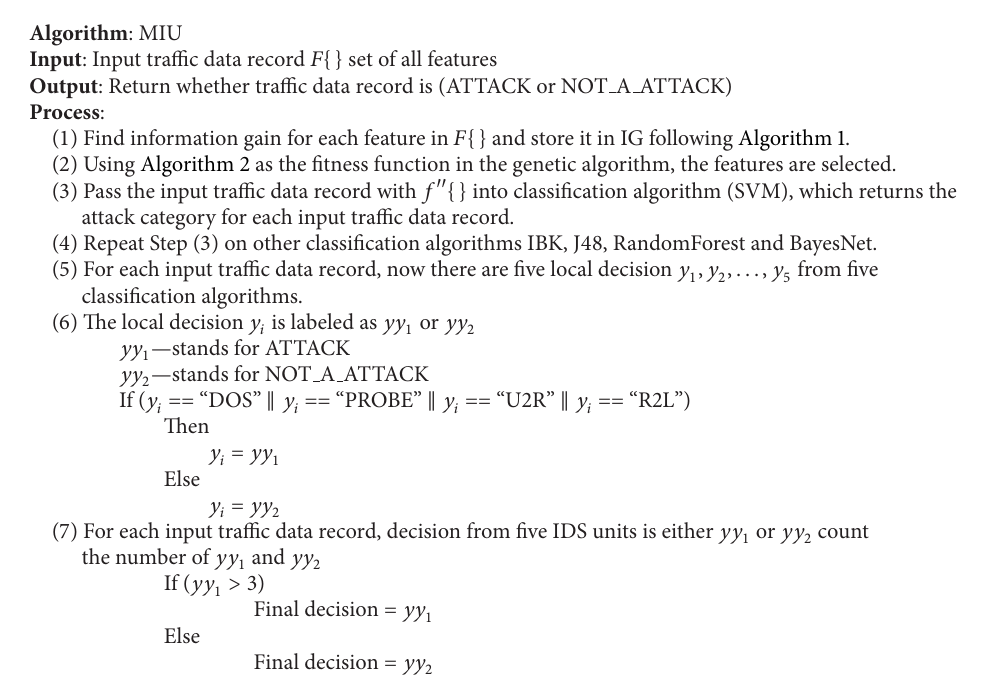
Algorithm 3: The proposed system algorithm.